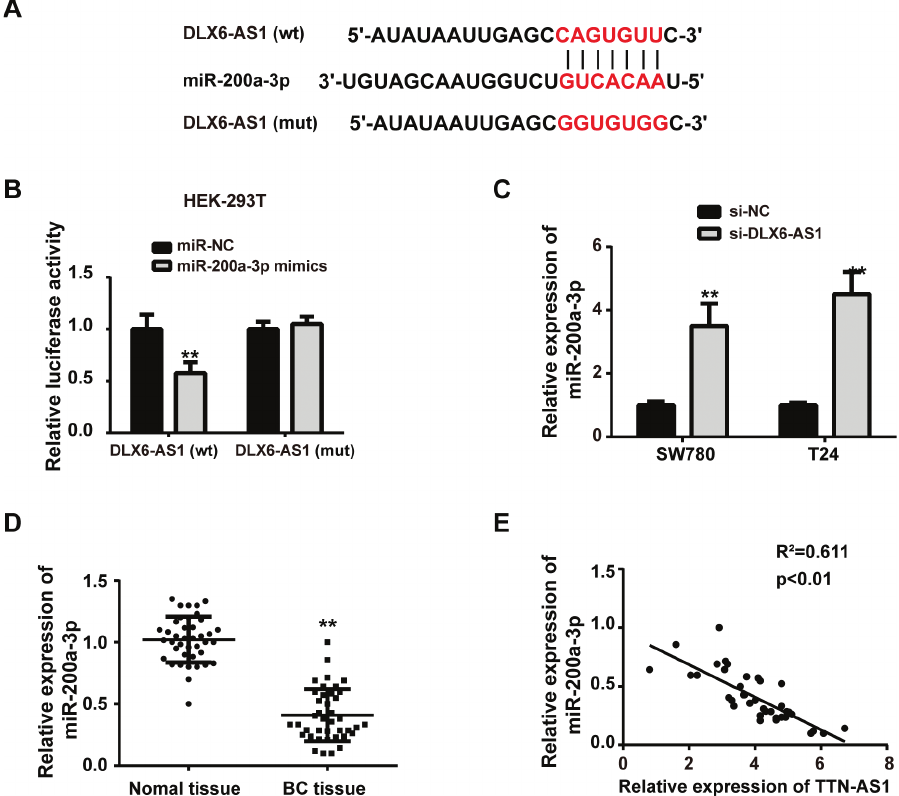
Fig. 3. DLX6-AS1 interacted with miR-200a-3p directly. (a) The binding sites between miR-200a-3p and DLX6-AS1 (StarBase v.2.0.) (b) The interaction between DLX6-AS1 and miR-200a-3p was confirmed via the luciferase assay. (c) miR-200a-3p was up- regulated after transfection of si-DLX6-AS1. (d) RT-qPCR measured the expression of miR-200a-3p in OS tissues and adjacent normal tissues. (e) DLX6-AS1 was negatively correlated with miR-200a-3p. NC, negative control. ** P < 0.01, versus miR-NC, si-NC or normal